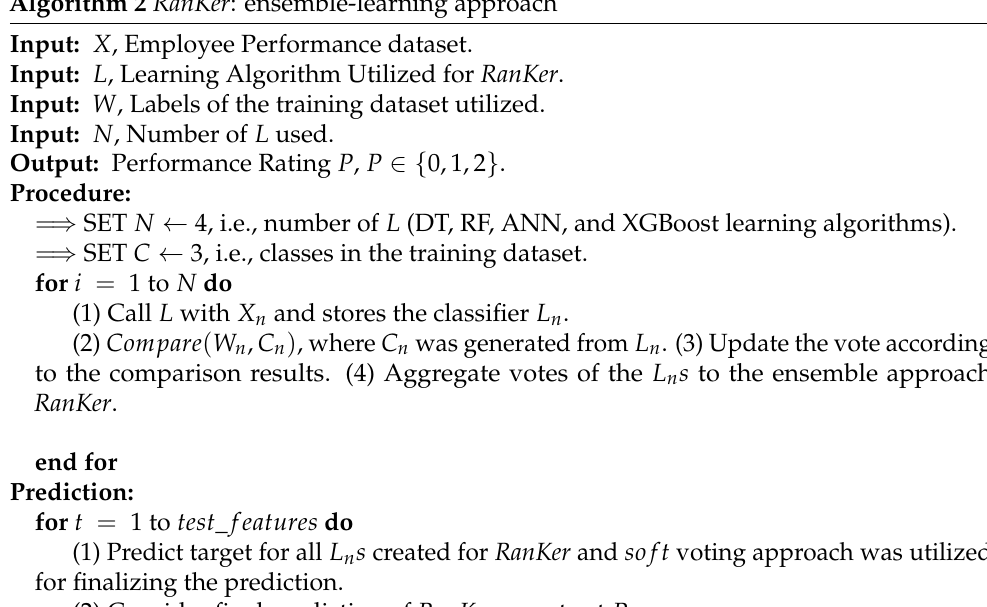
Algorithm 2 RanKer : ensemble-learning